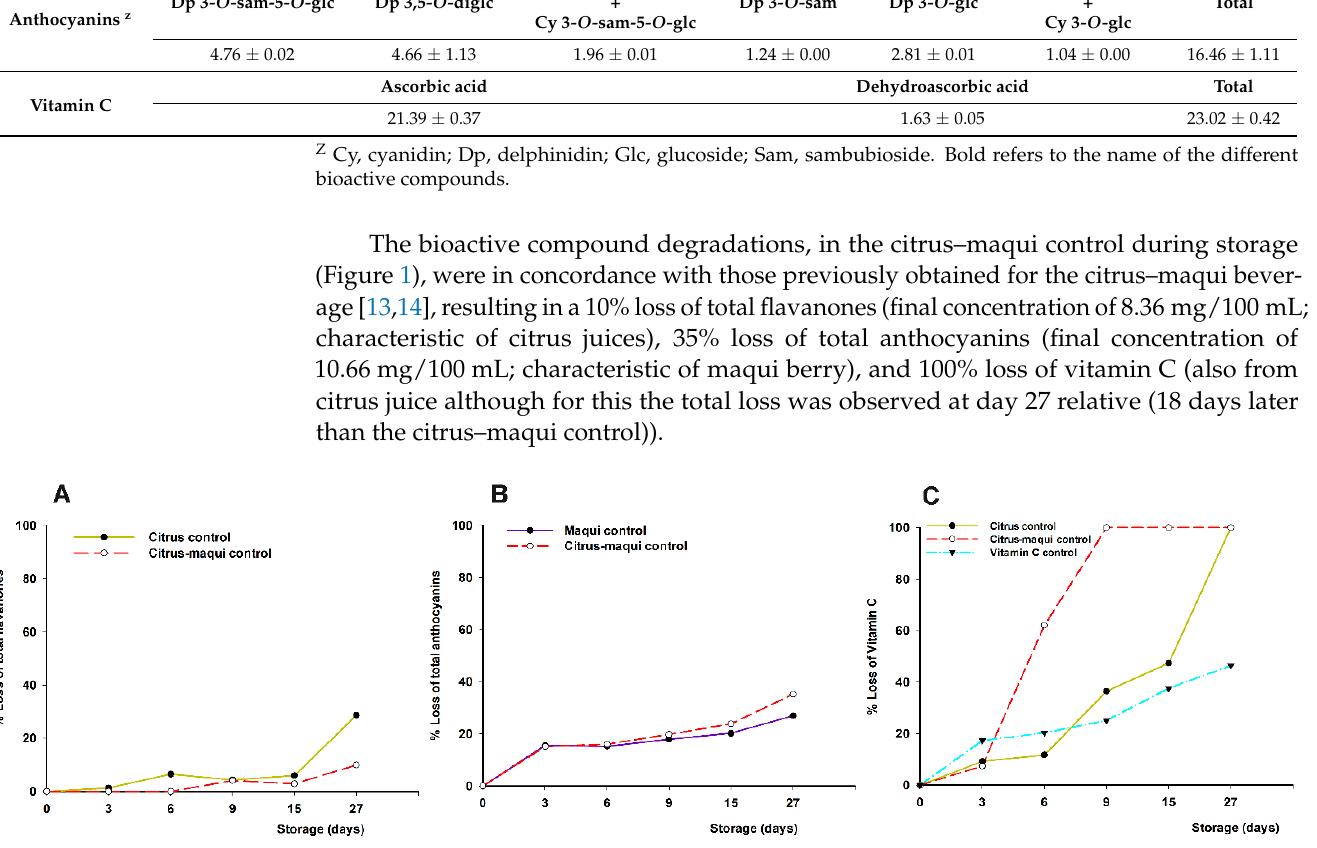
Figure 1. Percentage of loss of bioactive compounds (flavanones ( A ), anthocyanins ( B ), and vitamin C ( C )) in citrus–maqui control beverages, citrus juice (citrus control), maqui control solution, and ascorbic acid control solution, measured during 27 days storage at 4 °C. Significantly different final concentration absolute values according to statistical analysis ( t -test or ANOVA and Tukey’s multiple rank test) were found p < 0.01 and p < 0.001, for ( A ) and ( C ), respectively, while no significant differences were found for ( B ).